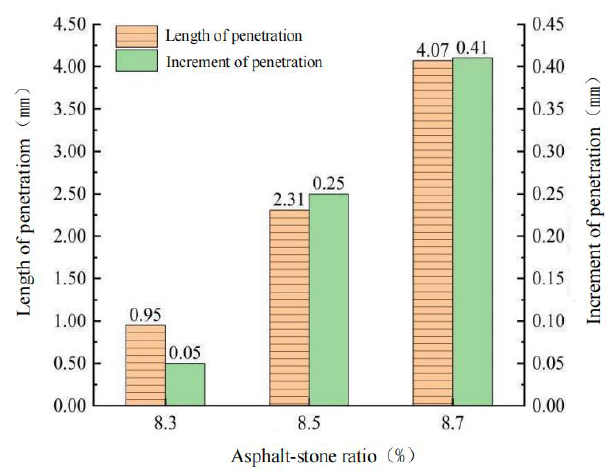
Figure 7. Test results of penetration and penetration increment with different oil–stone ratio.